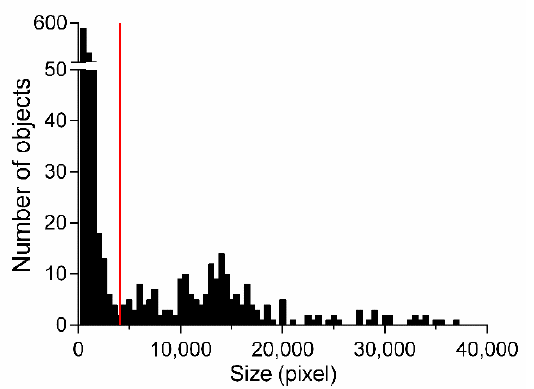
Figure 5. Histogram of all classified areas measured in test sets TS1-3 based on attribute subset 1.